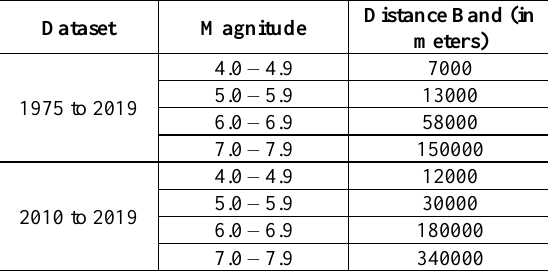
Table 1. Distance Bands used for Hot Spot Analysis